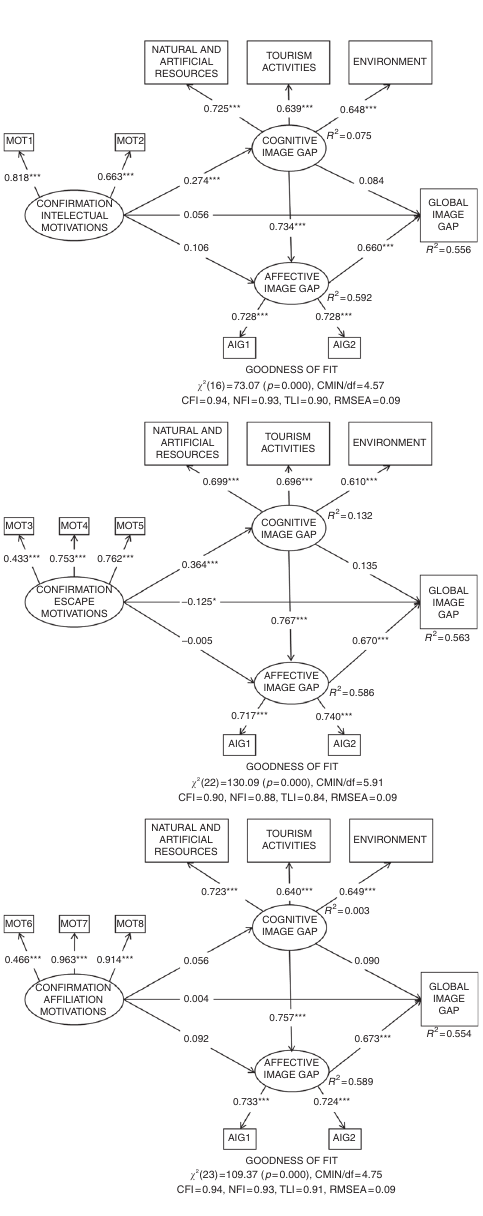
Figure 2. Results